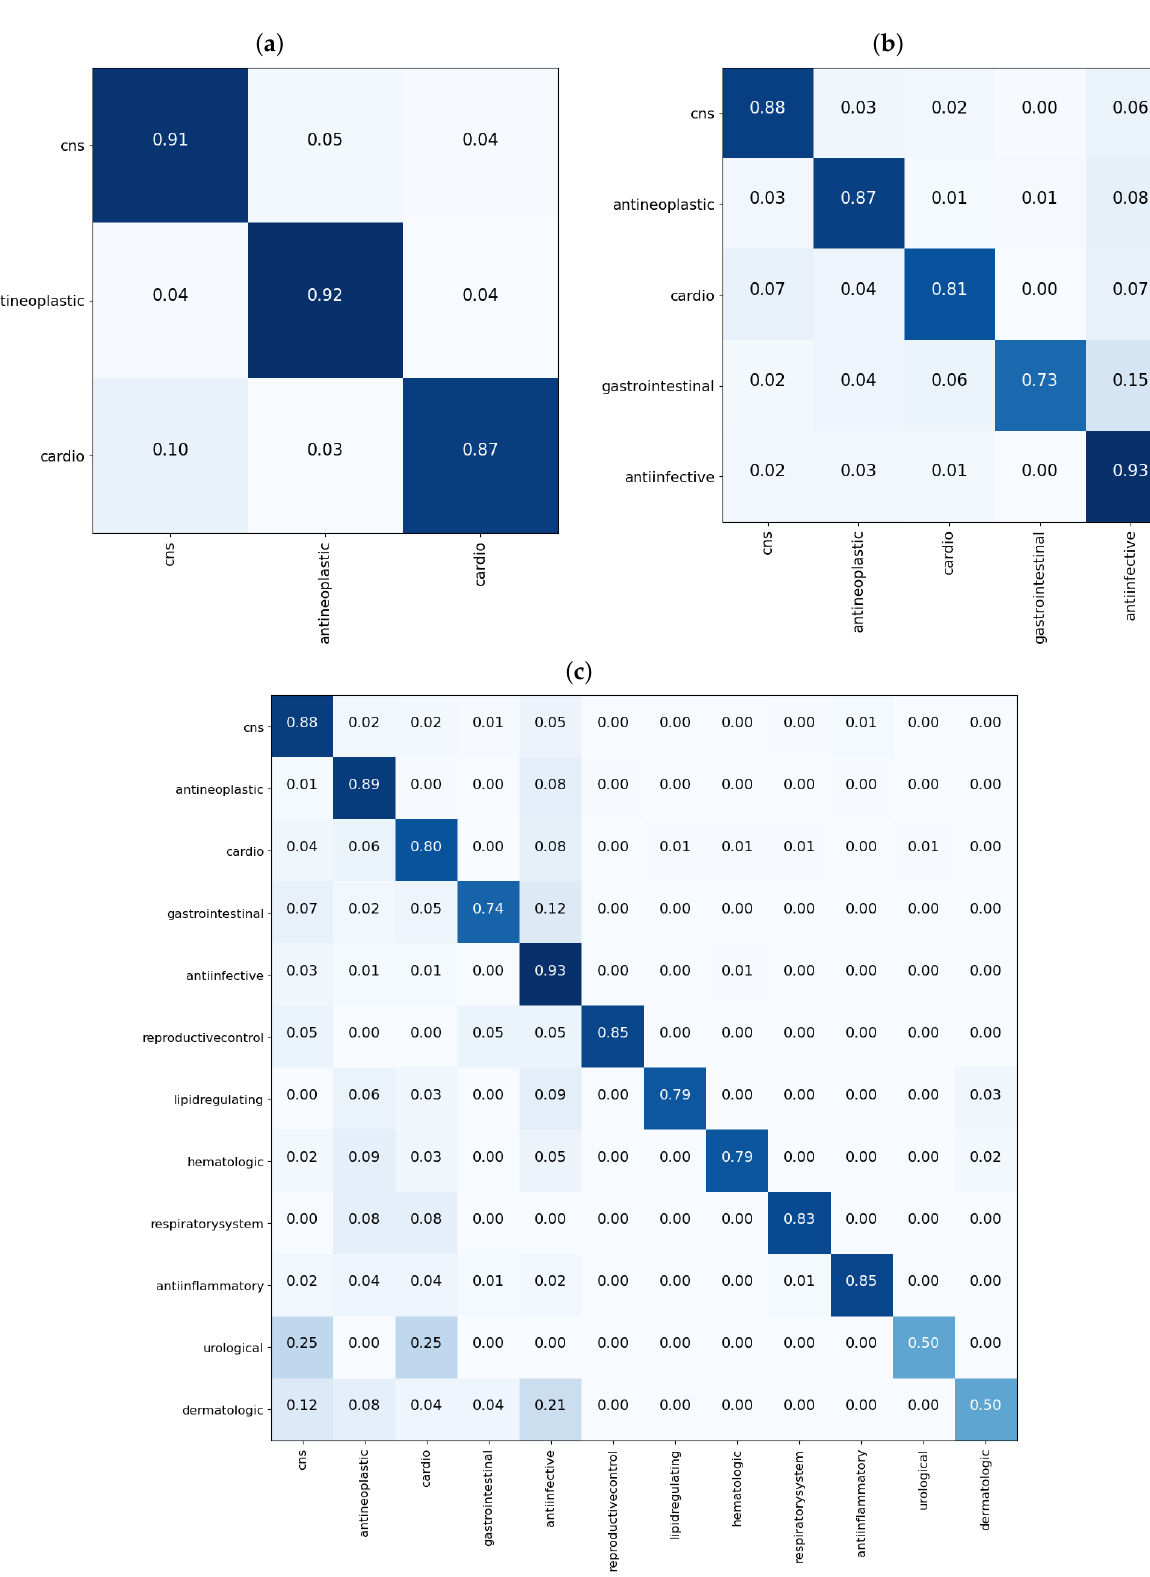
Figure 3. Confusion matrices showing performance of the GCN models on the fifth fold of the validation data for the single label tasks. In ( a ), results for the 3-task subgroup; in ( b ), results for the 5-task subgroup; and in ( c ), results for the 12-task subgroup. Each matrix shows the proportion of each predicted class, on the x-axis, for molecules in each true class on the